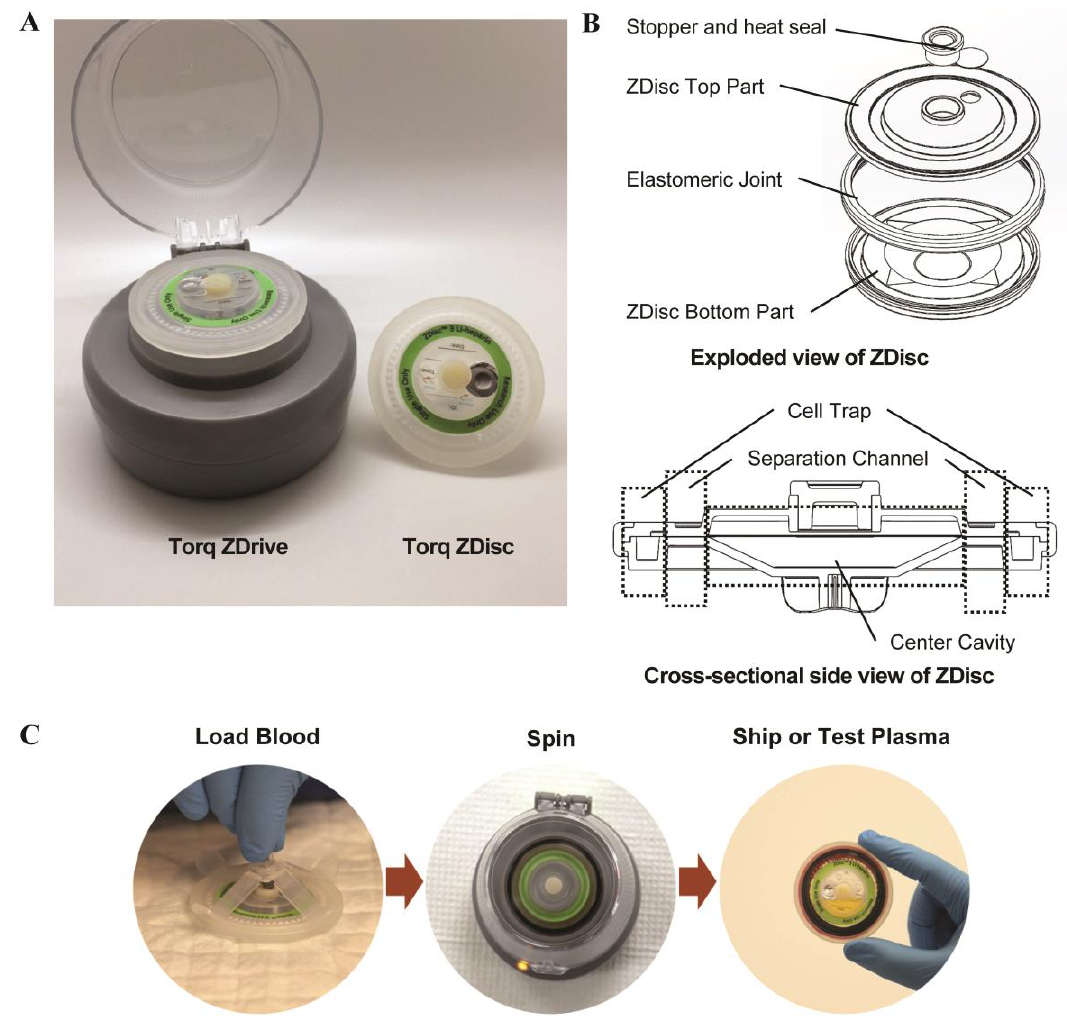
Figure 1. ( A ) Torq Zero Delay Centrifugation System. ( B ) Schematic representation of Torq ZDisc showing main components (Top; exploded view) and key structural features (Bottom; cross-sectional side view). ( C ) Three-step workflow of ZDisc: load, spin, and preparation for shipping or testing of plasma .